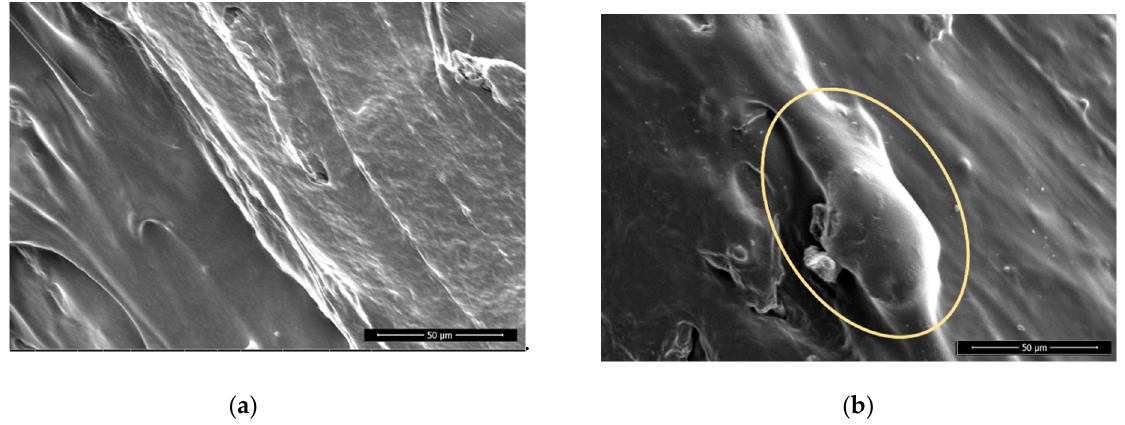
Figure 5. Wood-PLA, non-sanded, non-treated ( a ) and plasma treated ( b ), 1000× magnification. Melted materials are en- circled.